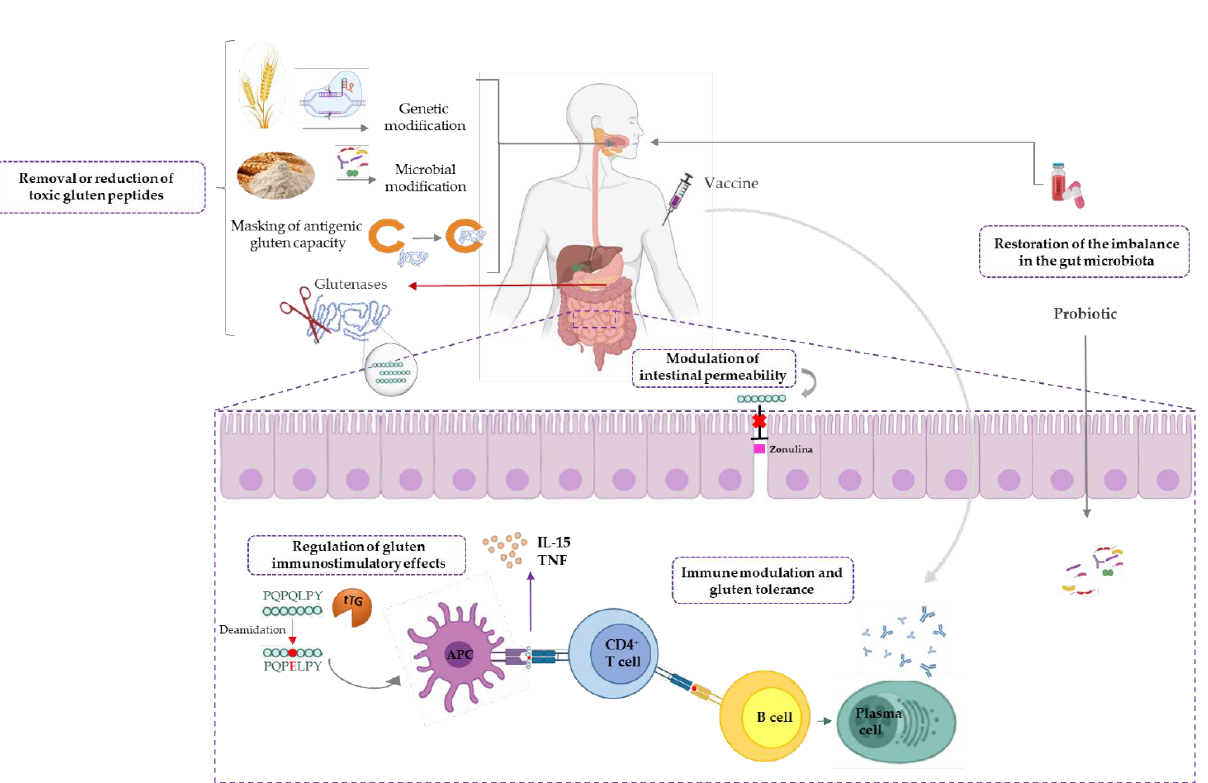
Figure 2. Emerging therapeutic approaches for non-dietary CD treatment. APC, antigen-presenting cell; CD, celiac disease; IL-15, interleukin 15; TNF, tumor necrosis factor; tTG, tissue transglutaminase. Table 1. Summary of strategies for CD grouped according to their